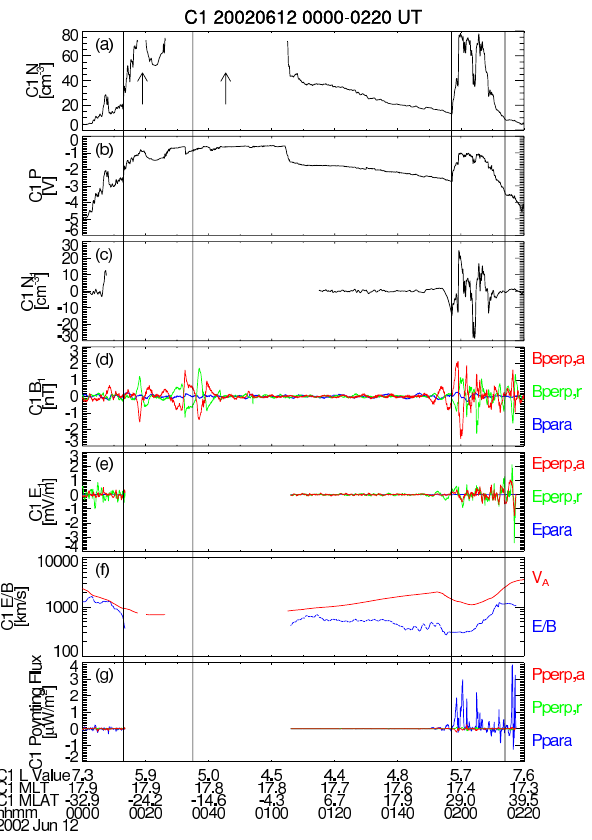
Fig. 5. C1 data including inbound and outbound plume crossings from 00:00 to 02:20UT on 12 June 2002. The figure shows (a) the number density, (b) spacecraft potential, (c) density fluctuations, (d) magnetic fluctuations, (e) electric fluctuations, (f) E/B ratio together with the Alfv´en velocity, and (g) Poynting flux. Spacecraft locations are noted in the bottom of the figure. Each plume crossing is indicated by pairs of vertical lines. Two arrows in panel (a) have the same meaning as those in Fig. 3.